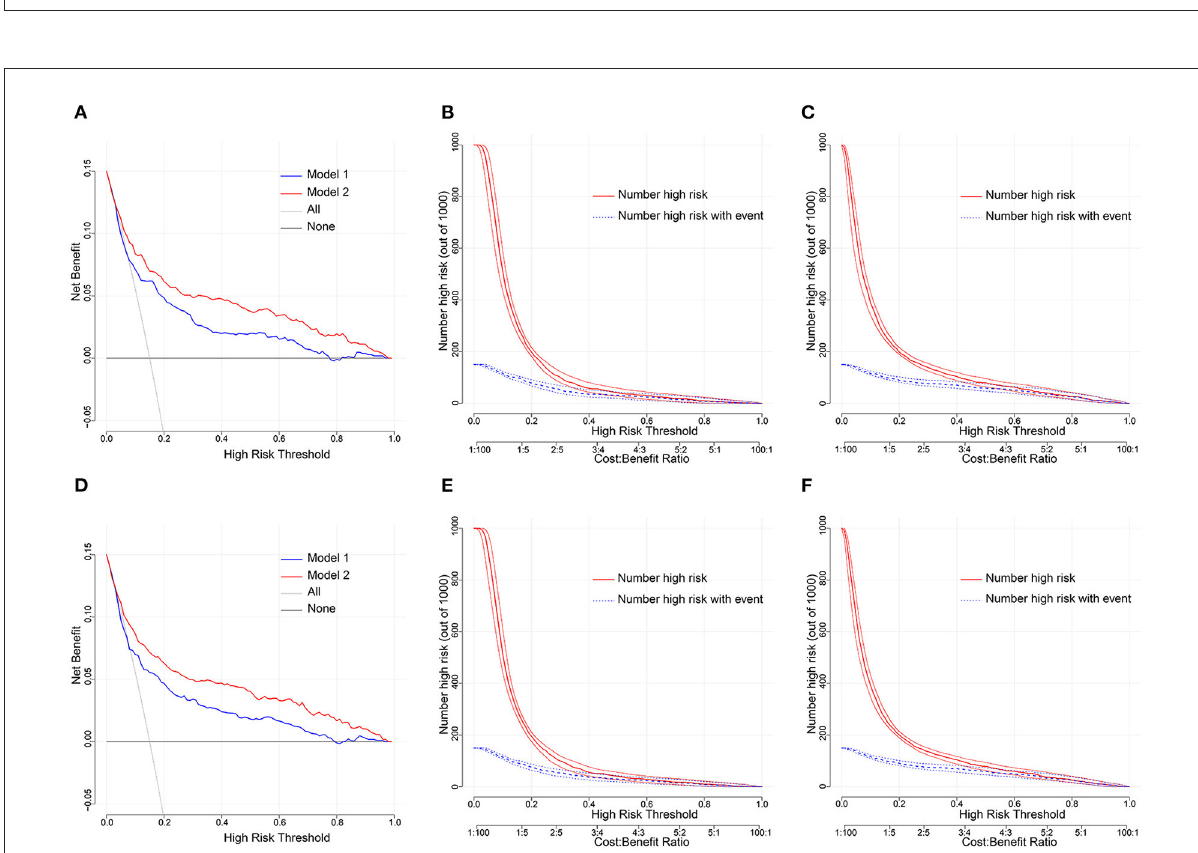
FIGURE7 (A,D) Decision curve analysis for the Model 1 and Model 2 nomogram in the training and validation cohort. The y and x axis means the true and false positive rate of the risk prediction of AFDAS patients, respectively. The blue line represents the Model 1 nomogram. The red line represents the Model 2 nomogram. (B,C) Clinical impact curve in the training cohort; (E,F) Clinical impact curve in the validation